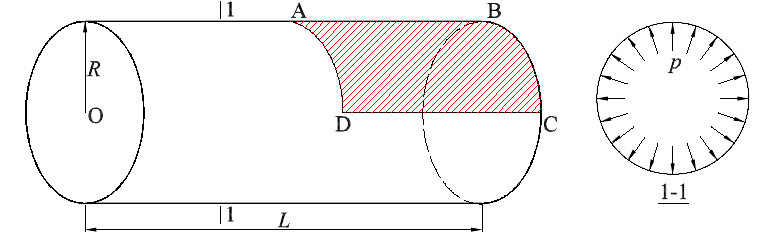
Figure 14. A fully clamped composite circular cylinder subjected to an internal pressure, ABCD is one eighth of the